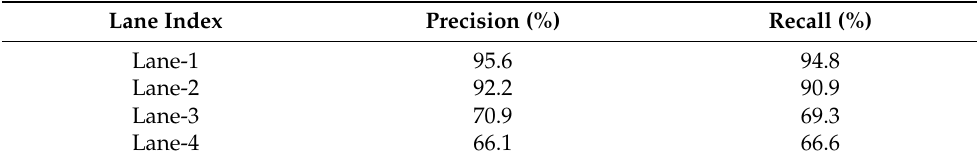
Table 7. Classification Result of LLNet (vision and perception